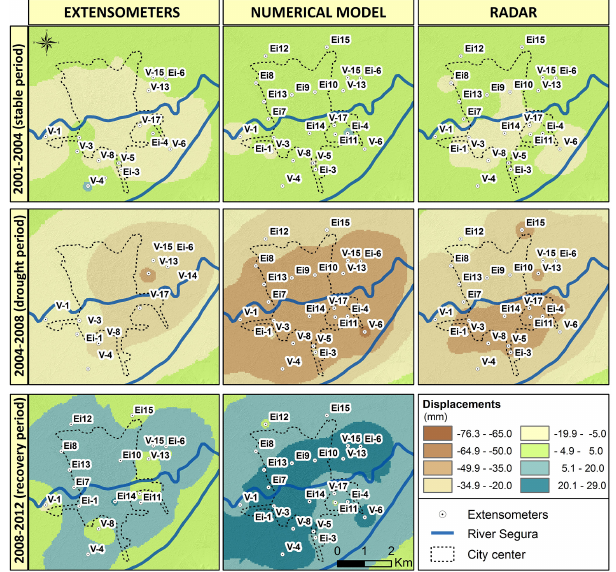
Figure 4. Spatial interpolation of the measured and computed dis- placements over the three considered periods: 2001–2004 (stable period), 2004–2008 (drought period), 2008–2012 (recovery period); redrawn after Tessitore et al.